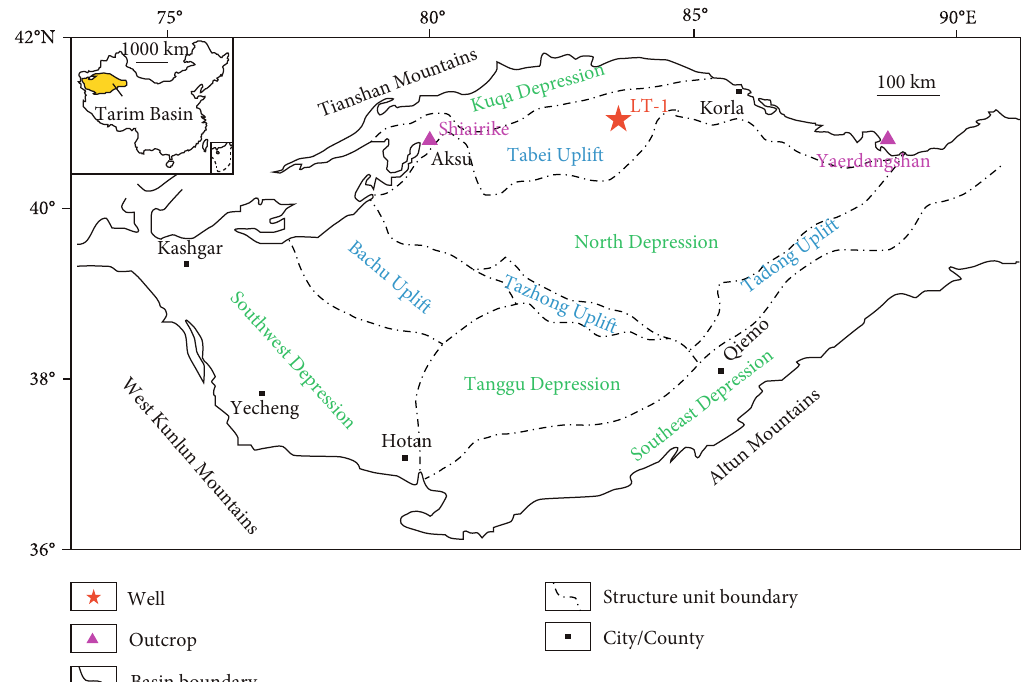
Figure 1: Tectonic unit distribution in the Tarim Basin [29, 30] and the location of well Luntan 1 (LT-1)